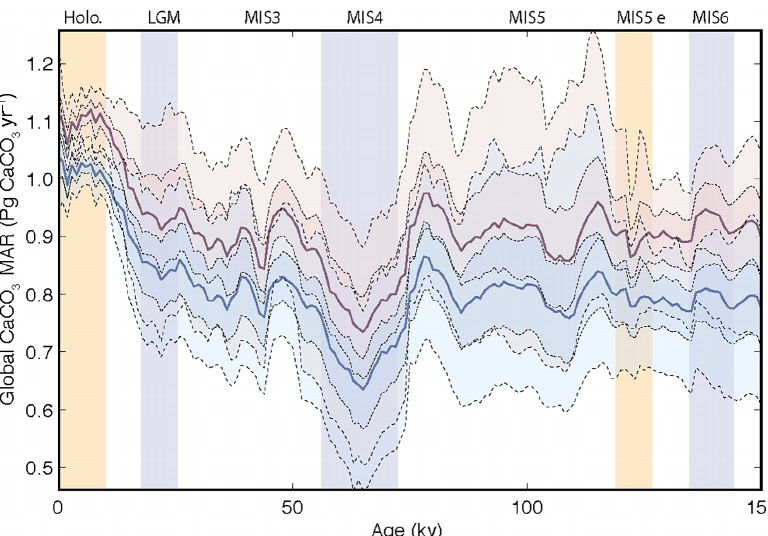
Figure A3. Global carbonate burial using two different modern MAR maps. Lines and shaded areas show the reconstructed time histories of global carbonate burial using a modern carbonate MAR map based on sedimentary data (red) and on a metamodel tuned to fit the sedimentary data (blue); see also Fig. 2. The distribution shown by dotted lines and shaded areas (5th, 25th, 50th, 75th, and 95th percentiles) was calculated from a bootstrap experiment performed on the 20 province maps used in the study.